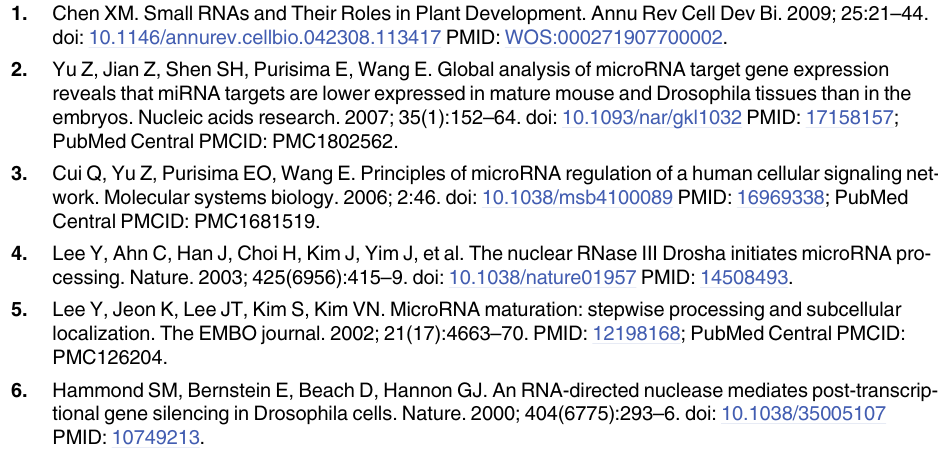
S1 Table. RT-PCR primers of the selected miRNAs. (cid:1) indicates a high CG content in a partic- ular miRNA sequence; thus, a primer cannot be synthesized. 5S is the reference gene. S2 Table. Statistics of the unique and total read alignments of wild and mutant strains from GenBank and Rfam databases. S3 Table. miRNA targets confirmed by degradome sequencing. S4 Table. Predicted miRNAs identified as differentially expressed in mutant and wild wild/mutant)| > 1. libraries using the selection criterion of |fold-change (log 2 S5 Table. Specifically and differentially expressed miRNAs analyzed by the combined RNA sequencing and degradome